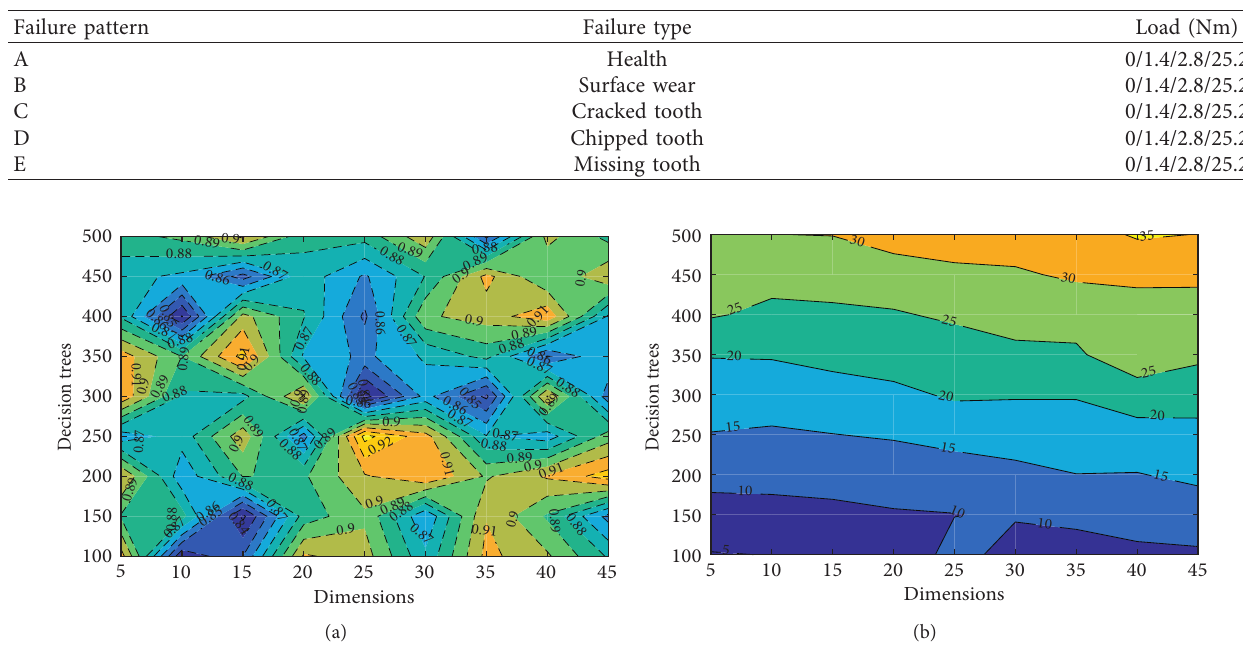
Table 1: Planetary gearbox conditions.